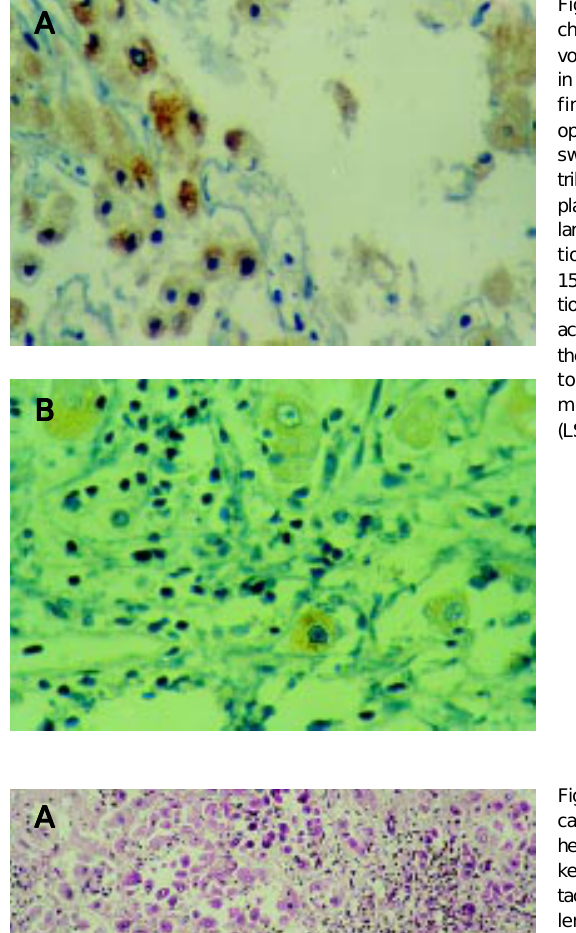
Figure 3. Histopathologi- cal aspects of extensive hepatic necrosis. A , Shrun- ken hepatocytes are